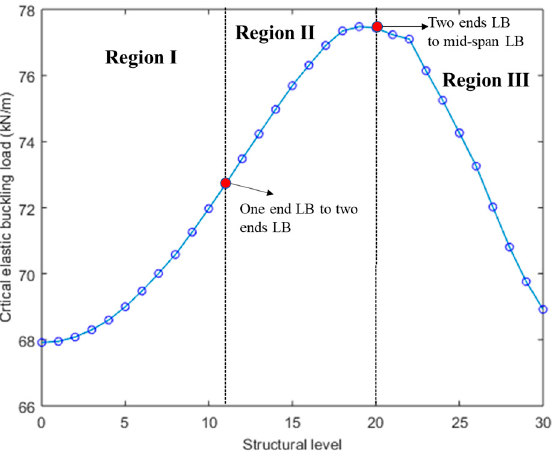
Figure 26. The elastic buckling loads (Wc) of different structural level (SL) perimeter beams.